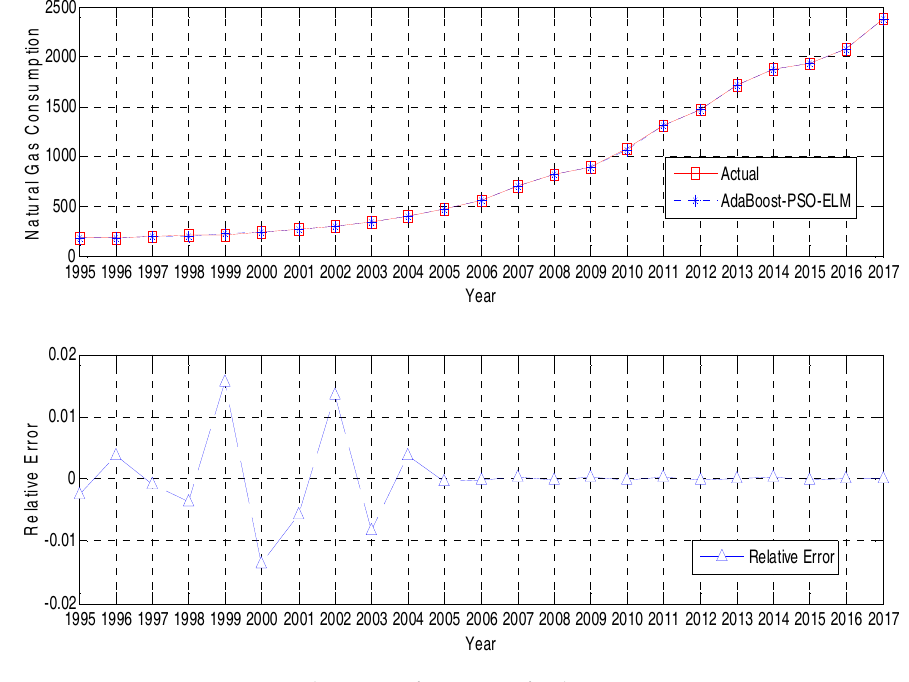
Figure 8. Prediction Performance of AdaBoost-PSO-ELM.